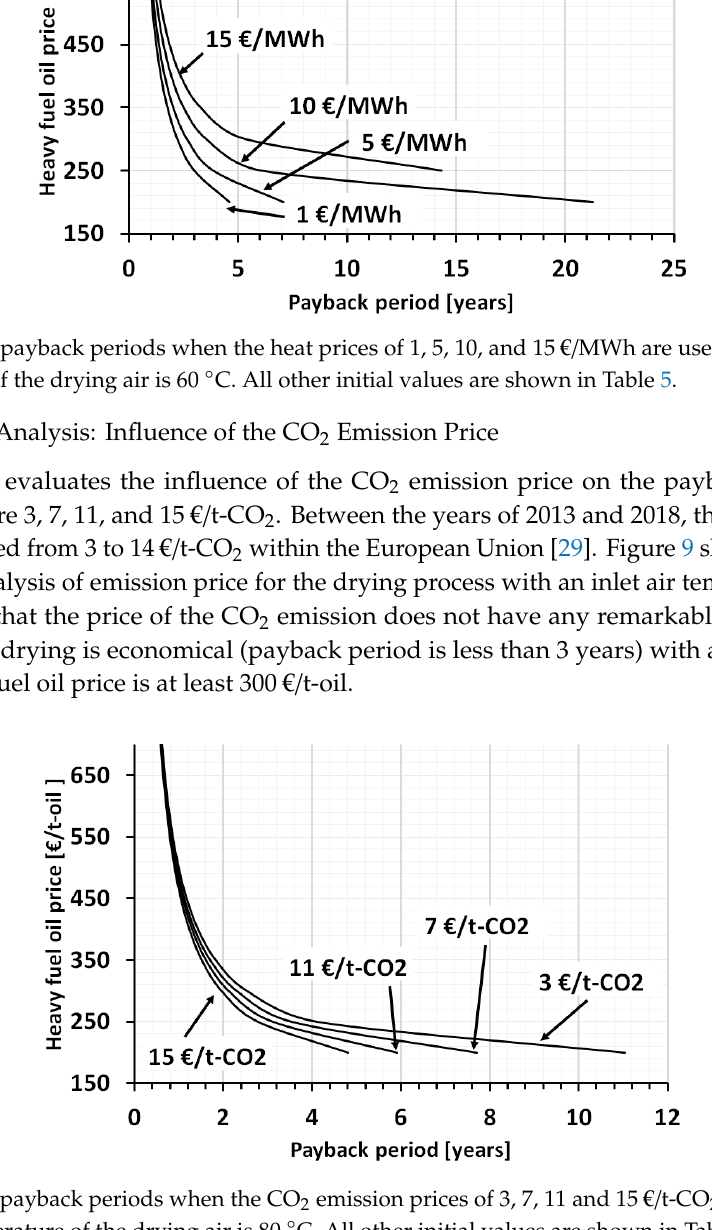
Figure 7. The payback periods when the heat prices of 1, 5, 10, and 15 €/MWh are used. The inlet air temperature of the drying air is 80 °C. All other initial values are shown in Table 5.